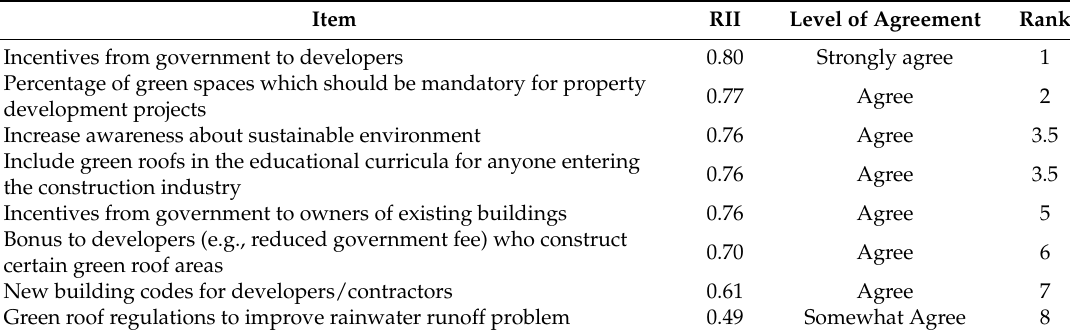
Measures to enhance the implementation of extensive green roof systems for new and existing buildings.